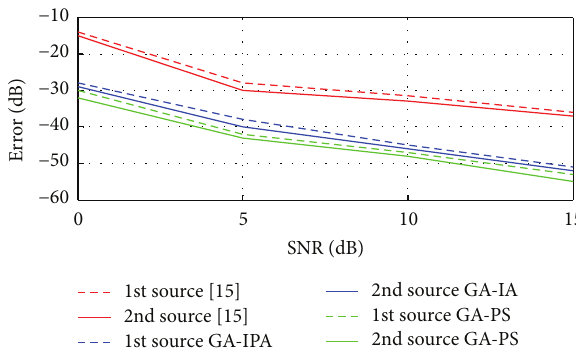
Figure 7: Error estimation of the elevation angles versus SNR.